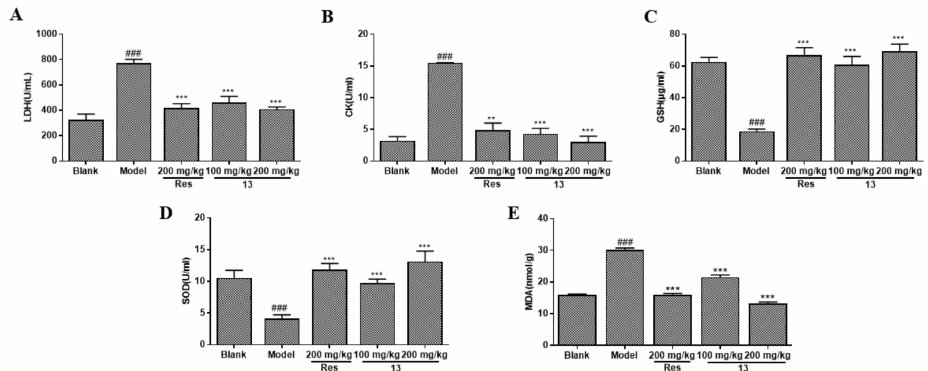
Figure 7. Compound 13 protected against myocardial injury in rats. Levels of LDH ( A ), CK ( B ), GSH ( C ), SOD ( D ) in serum and MDA ( E ) in myocardial homogenate in different treatment groups. ### p < 0.001 vs. blank. ** p < 0.001 vs. model. *** p < 0.001 vs.